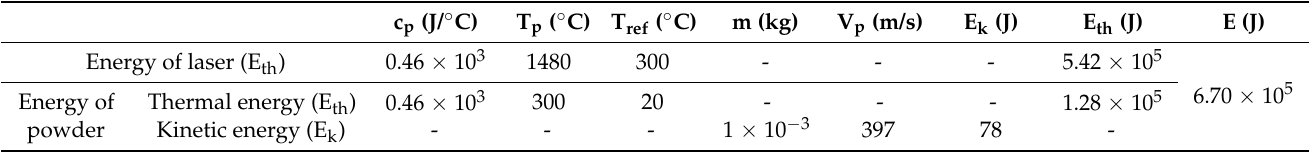
Table 8. Energy calculation of the HF